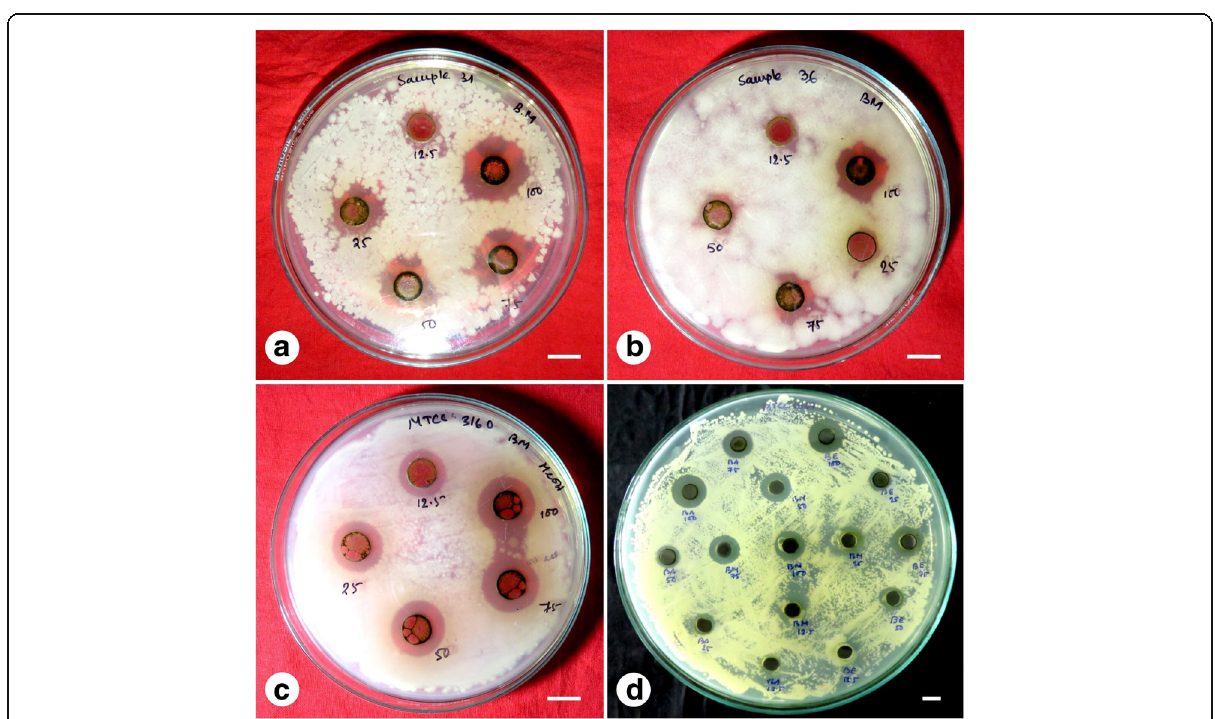
Fig. 2 Antimicrobial activities of Bacopa monnieri [bar = 10 mm]. a Activities of methanol extract against MDR-RTI clinical strain Klebsiella pneumoniae [Sample 31], ( b ) Activities of methanol extract against MDR-RTI clinical strain Klebsiella pneumoniae [Sample 36], ( c ) Activities of methanol extract against standard bacterial strain Staphylococcus aureus [MTCC 3160], ( d ) Activities of ethanol, methanol, and acetone extracts against standard fungal